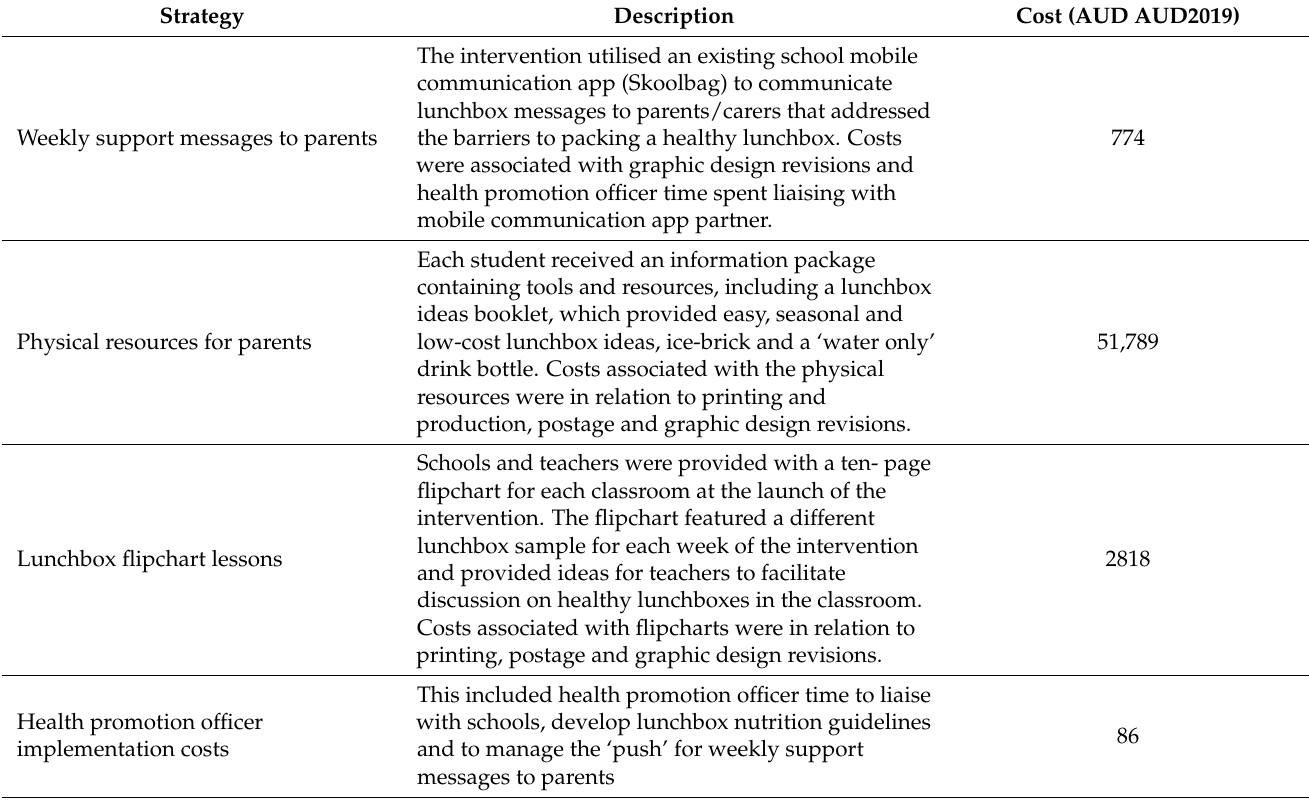
Table 3. Summary of strategy and